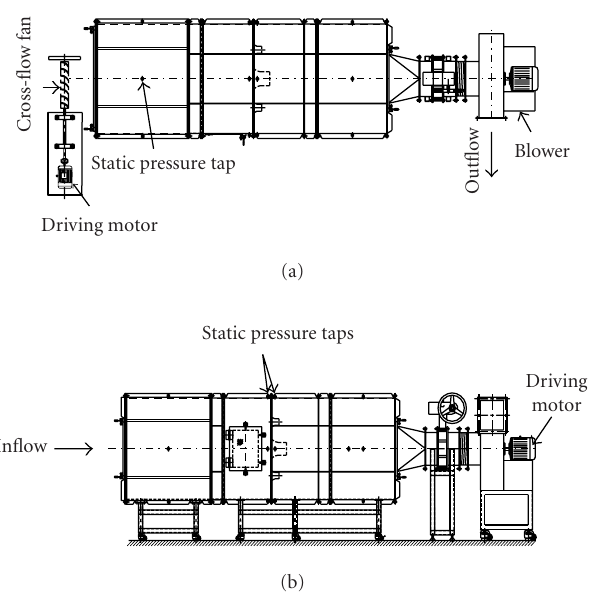
Figure 4: Schematic diagram of test setup.